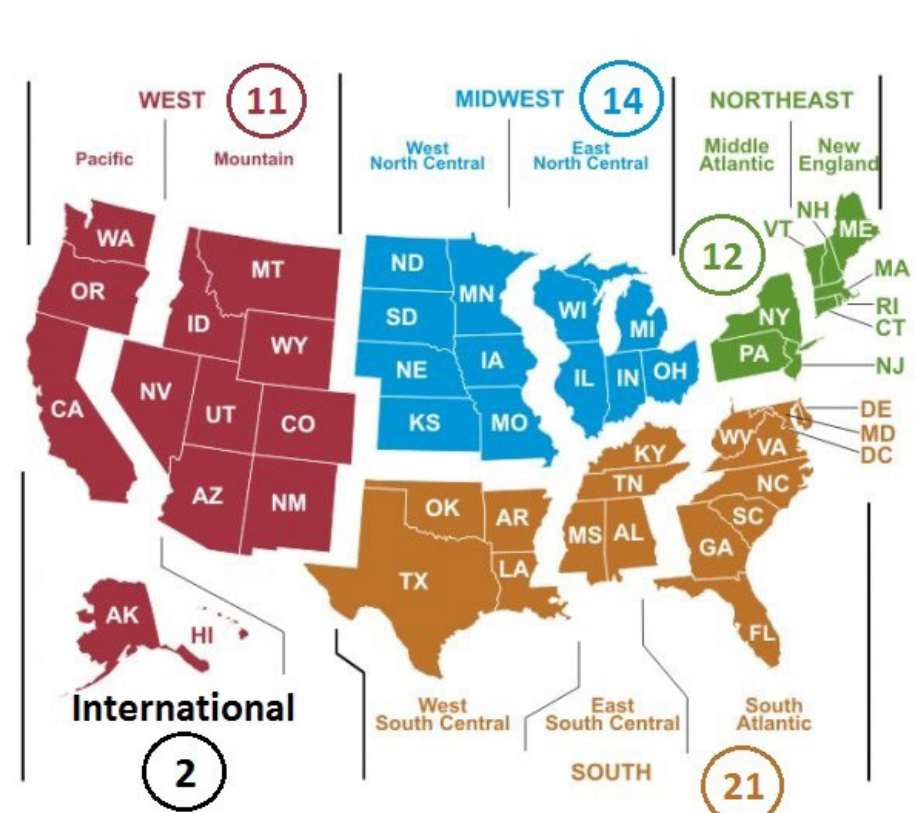
Figure 2. Geographic Representation of Focus Group Attendees, by